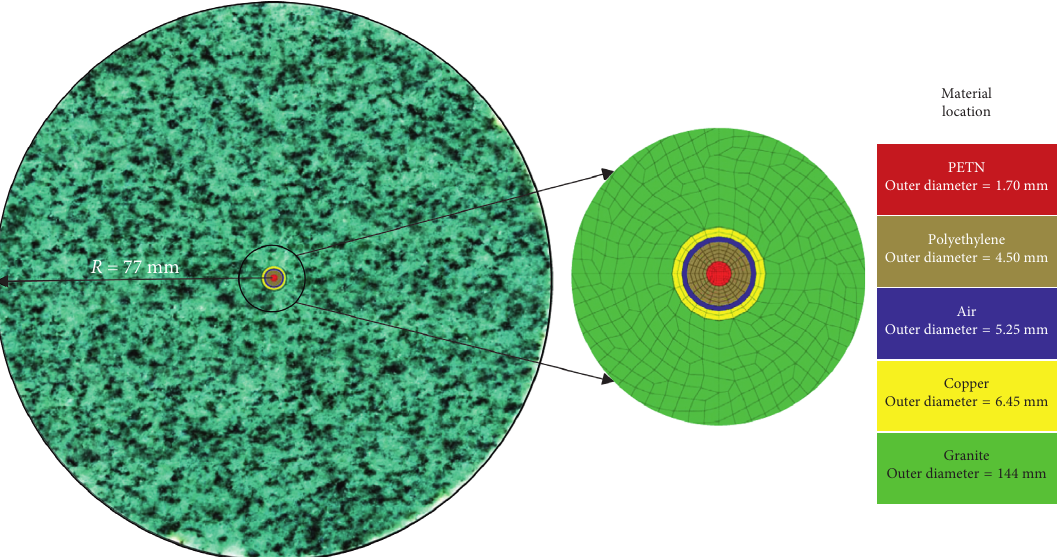
Figure 4: Combination of the model size and material locations. Table 1: RHT material parameters for